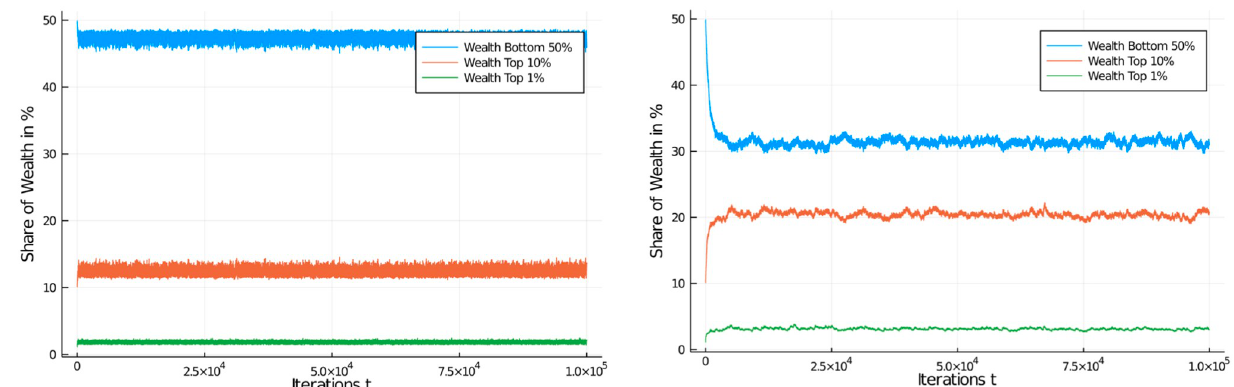
Fig 13. Comparison of wealth tax effects on quantiles. Wealth development in different quantiles of the population of 1,000 agents. Different flat wealth tax regime, with tax rate of of 60% (left) and 5% (right). Initial distribution was equal among all 1,000 agents. Quantiles shown: Bottom half of the population vs top 10% and top 1% wealthiest agents. Distributions quickly stabilize after a short relaxation period. https://doi.org/10.1371/journal.pone.0255719.g013 PLOS ONE | https://doi.org/10.1371/journal.pone.0255719 August 11,